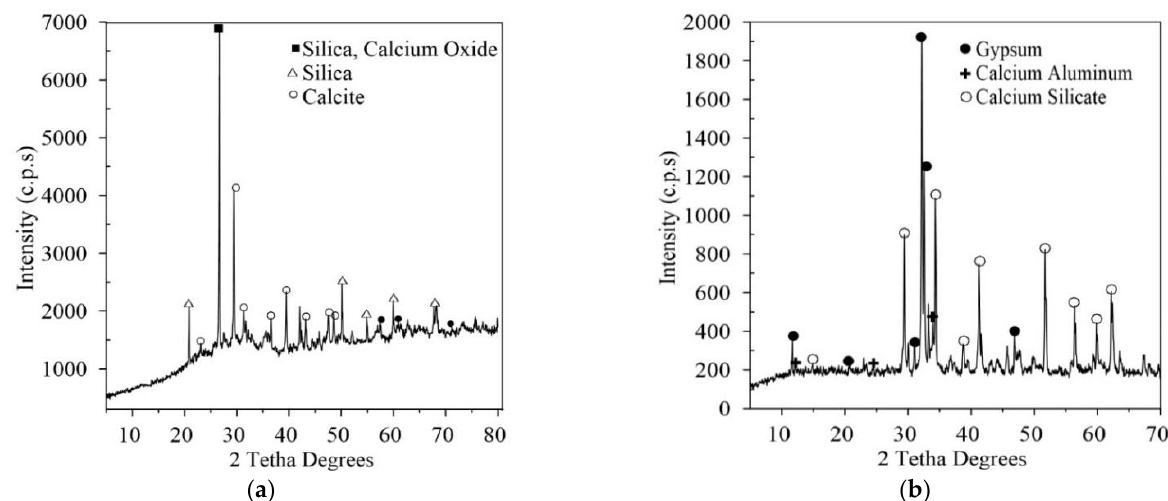
Figure 1. X-ray diffraction (XRD) pattern for MIBA ( a ) and for CEM I 42.5 R ( b ).